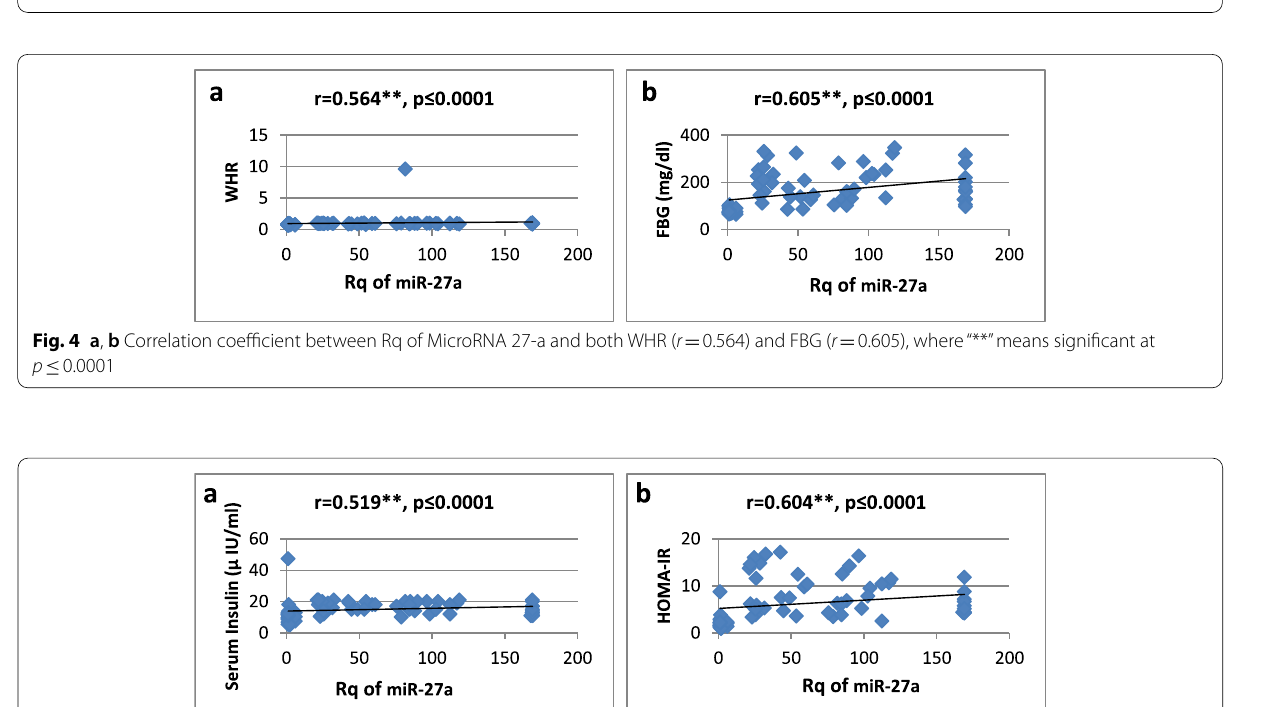
Fig. 3 a , b Correlation coefficient between Rq of MicroRNA 27‑a and both BMI ( r p